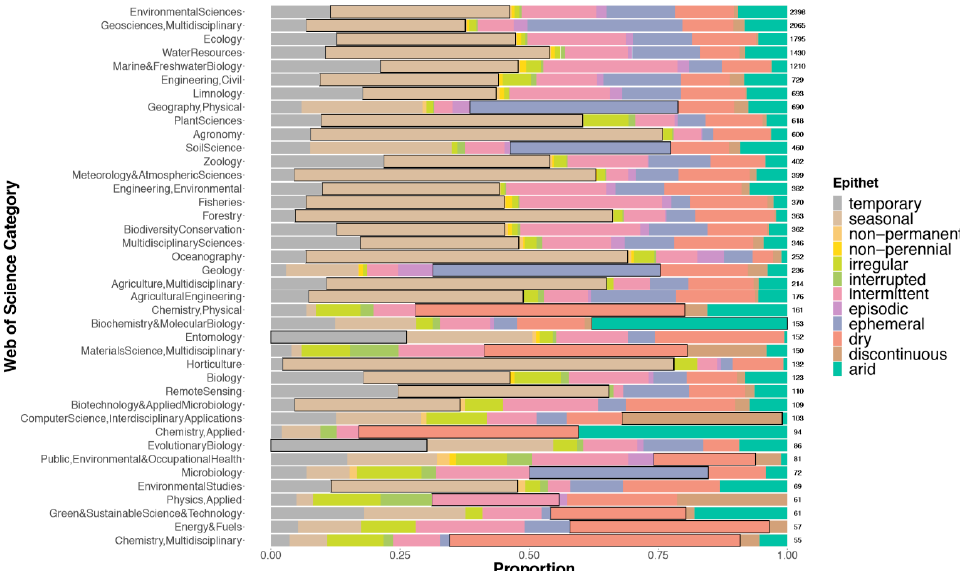
Figure 1. Proportion of epithets by Web of Science (WoS) category. Displayed are the 40 categories (out of 148 unique WoS categories) that contained at least 50 papers across all 12 epithet corpora on the y -axis. The proportion of each category made up of epithets is on the x -axis. Each color represents a different epithet, with the most dominate epithet per category highlighted in black. The total number of papers appearing in each category is displayed as the sample size along each column for reference (environmental sciences had the largest number with 2398 while multidisciplinary chemistry had the smallest with 55 papers).